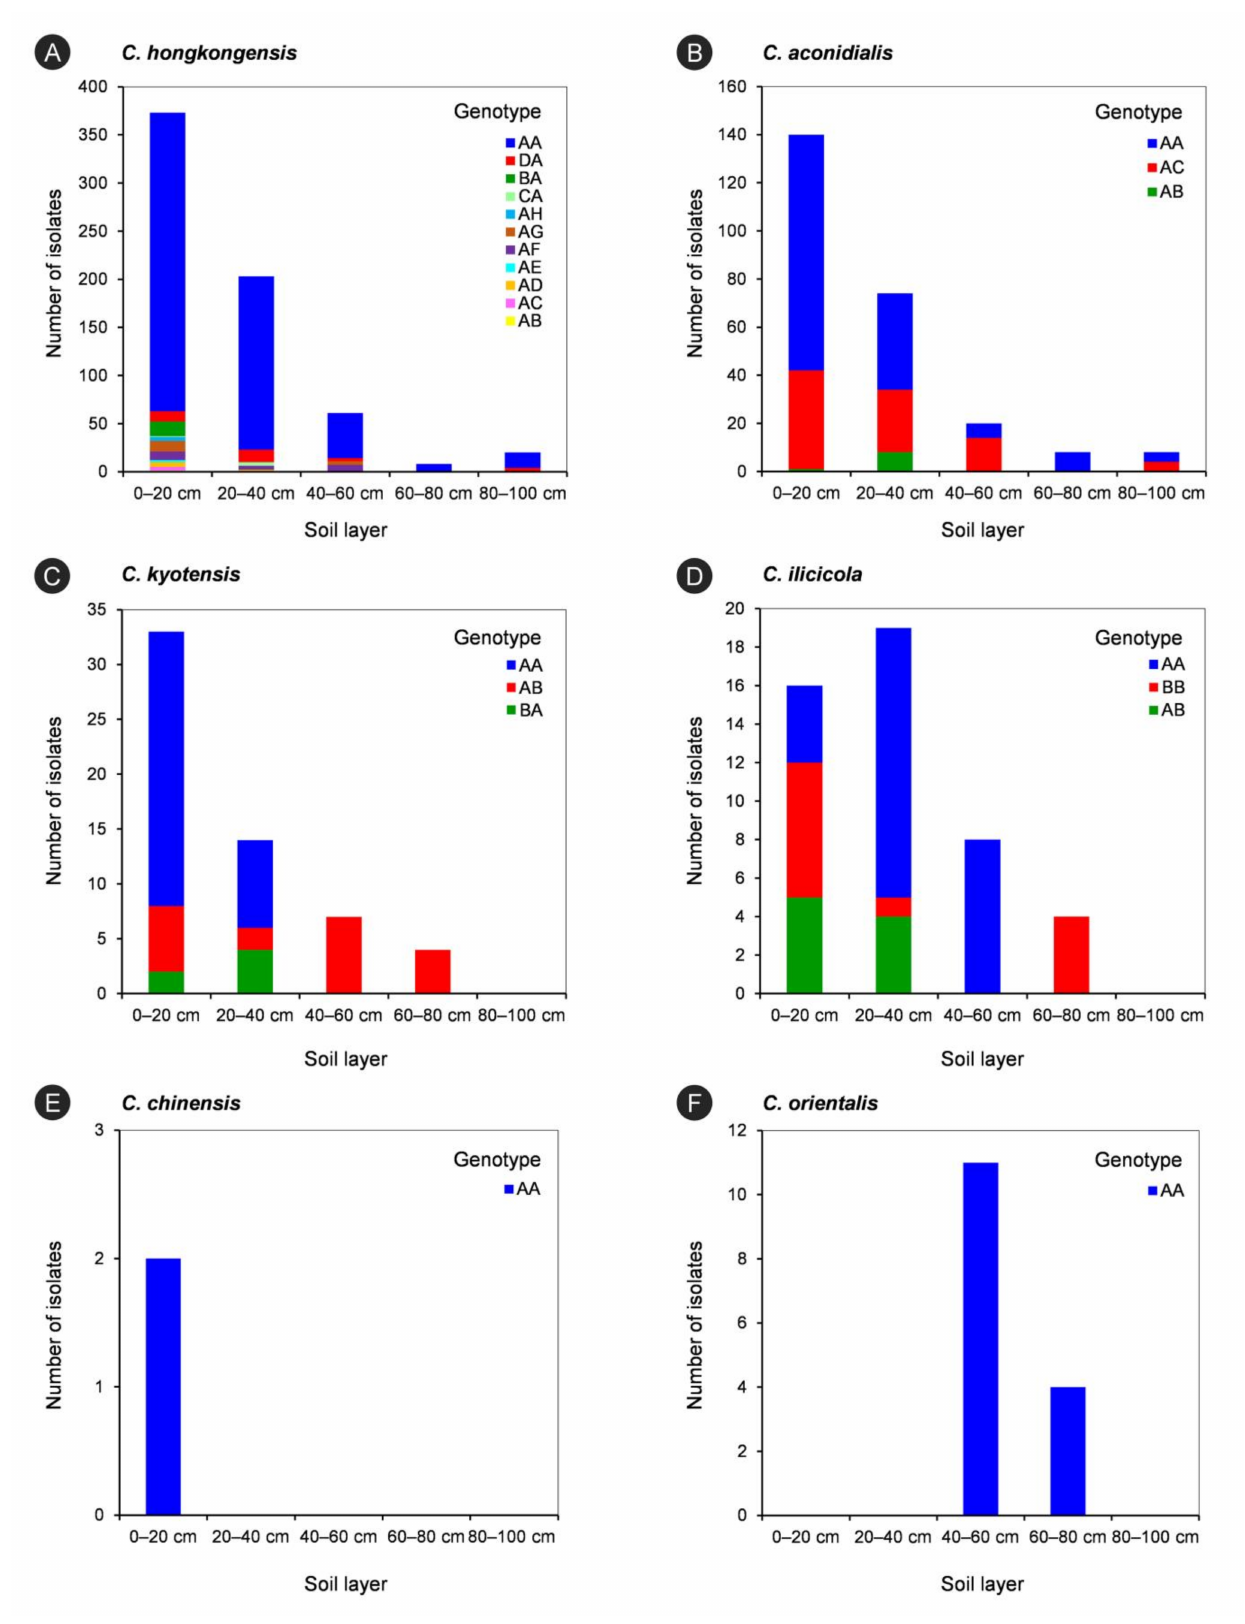
Figure 6. The isolate numbers of each genotype of each Calonectria species in five soils layers. The genotypes were determined by DNA sequences of tef1 and tub2 gene regions. ( A ): C. hongkongensis ; ( B ): C. aconidialis ; ( C ): C. kyotensis ; ( D ) C. ilicicola ; ( E ): C. chinensis ; ( F ): C. orientalis